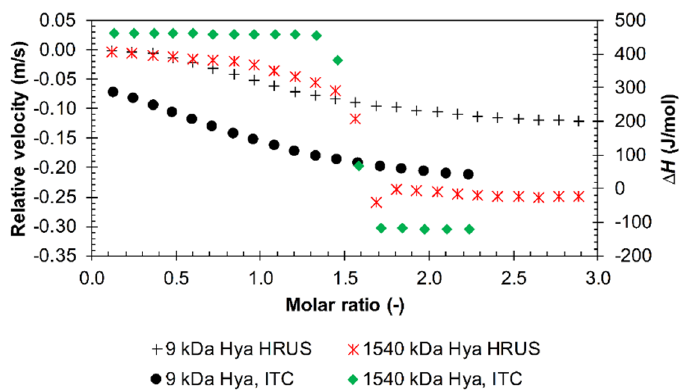
Figure 12. The comparison of HR-US and ITC titration records during the titration of arginine triacontamer (hydrochloride form) into 9 and 1540 kDa hyaluronan solutions in PBS (25 °C, 11.6 MHz).